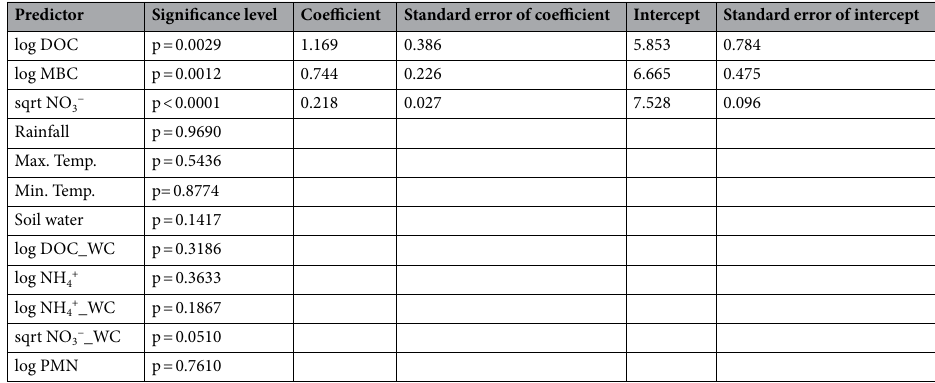
Table 1. Significant linear regression results for response of logged bacterial amoA gene abundance to each soil and environmental variable separately. Regression coefficients are only reported for significant relationships. sqrt square root transformed, log log transformed, Rainfall , cumulative rainfall of 30 days prior to sampling, Max. Temp. mean daily maximum soil temperature at 5 cm depth during 30 days prior to sampling, Min Temp mean daily minimum soil temperature at 5 cm depth during 30 days prior to sampling, Soil Water soil water content at time of collection, DOC dissolved organic carbon per gram of soil, DOC_WC dissolved organic carbon per gram of soil water, MBC microbial biomass carbon per gram of soil, NH 4 + ammonium per gram of soil, NH 4 + _WC ammonium per gram of soil water, NO 3 − nitrate per gram of soil, NO 3 − _WC nitrate per gram of soil water, PMN potentially mineralizable nitrogen per gram of